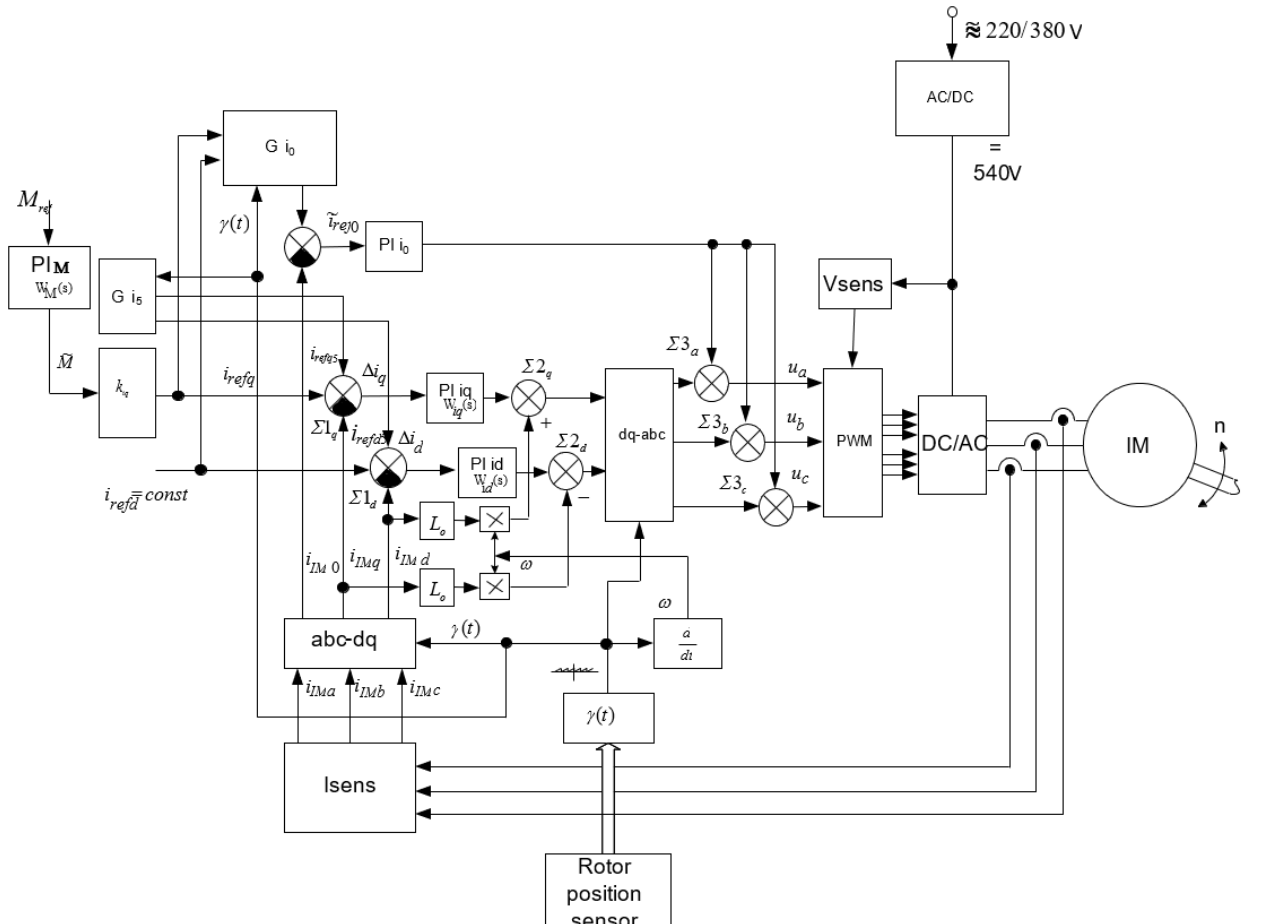
Figure 5. Algorithm of controlling an electric drive using a voltage inverter (VI). The shape of the assignment total signals along the orthogonal axes is shown in Fig- ure 6.